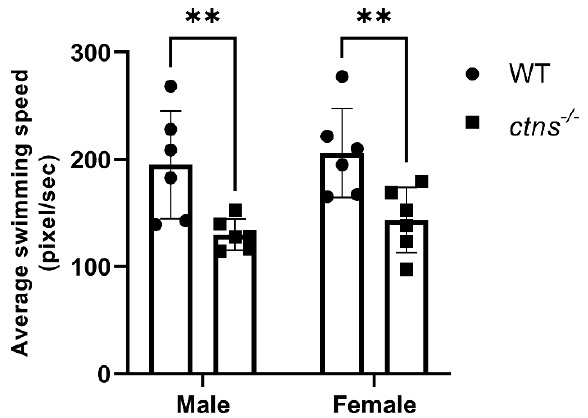
Figure 9. Average swimming speed in wild-type and ctns − / − zebrafish. The average speed is decreased in ctns − / − zebrafish compared with wild-type in both genders. The average swimming speed is measured in pixel/second. Each dot represents one zebrafish, for a total of n = 6 wild-type and n = 6 ctns − / − 18-month-old zebrafish. Two-way ANOVA with Fisher’s least significant difference (PLSD) test: ** p < 0.01.